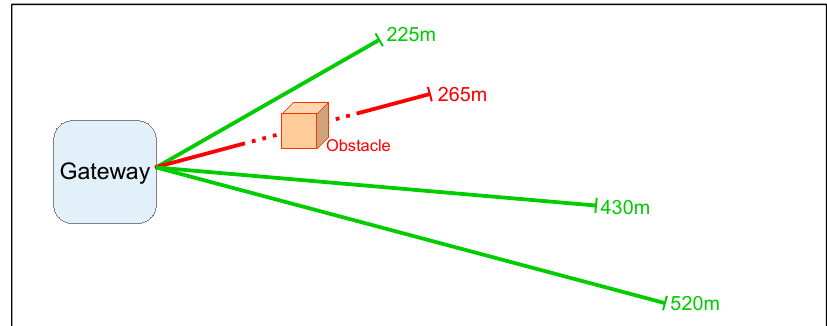
Figure 7. Tinovi sensor range tests 1: the industrial environment.